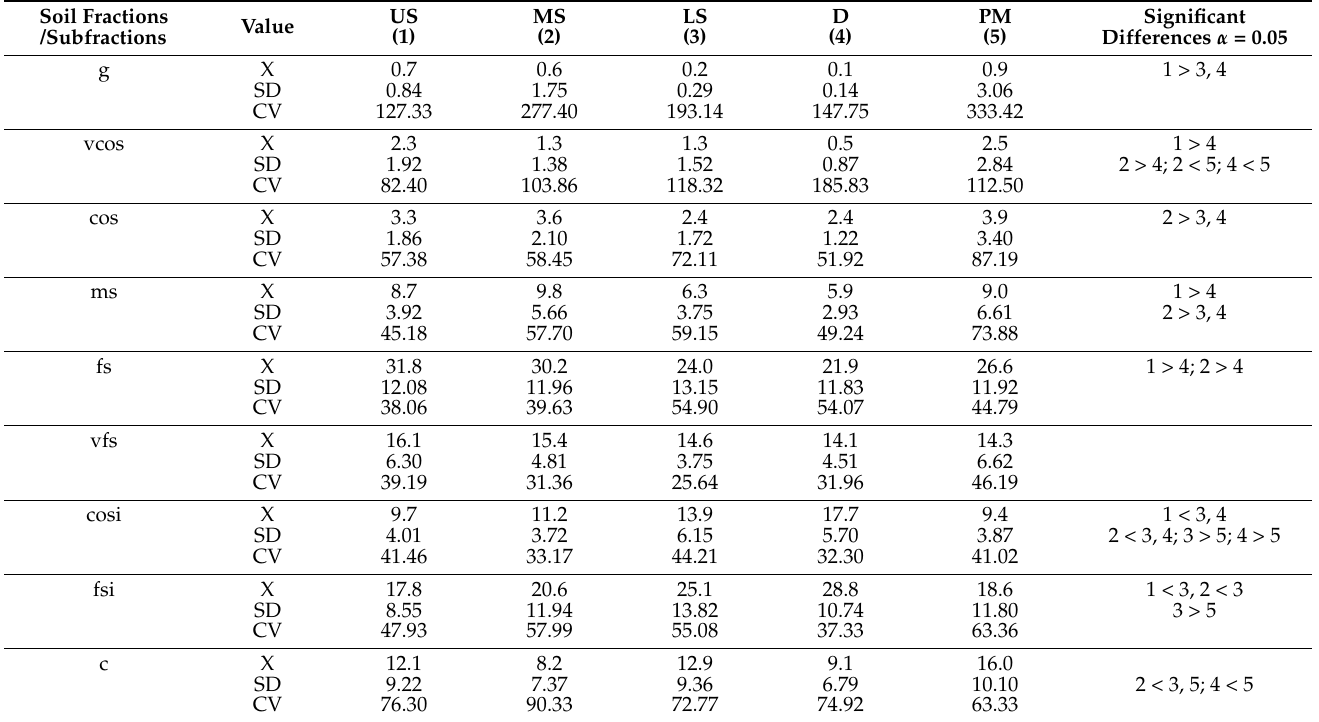
Table 3. Average amounts of soil fractions in humus horizons and parent material in moraine landscape, regarding the soil position at the